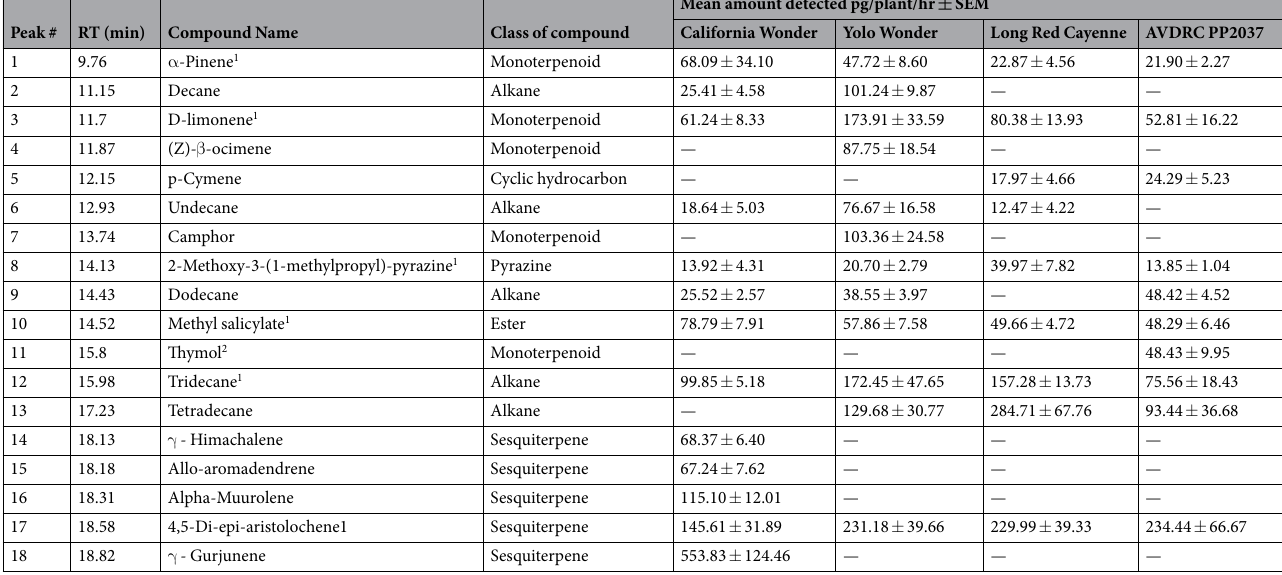
Table 2. Mean amount (pg/plant/hr ± SEM) of pepper root volatiles detected. 1 Compounds common to the four pepper plants and 2 compound specific to AVDRC PP0237.